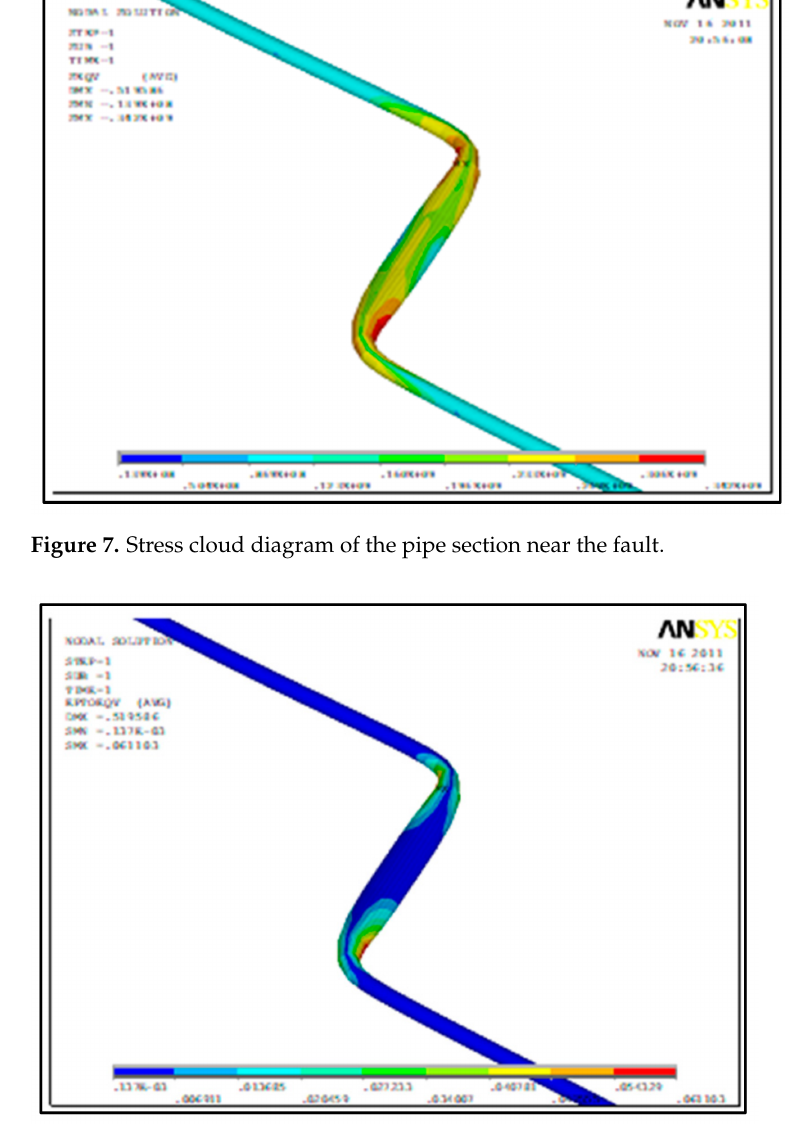
Figure 8. Strain cloud diagram of the pipe section near the